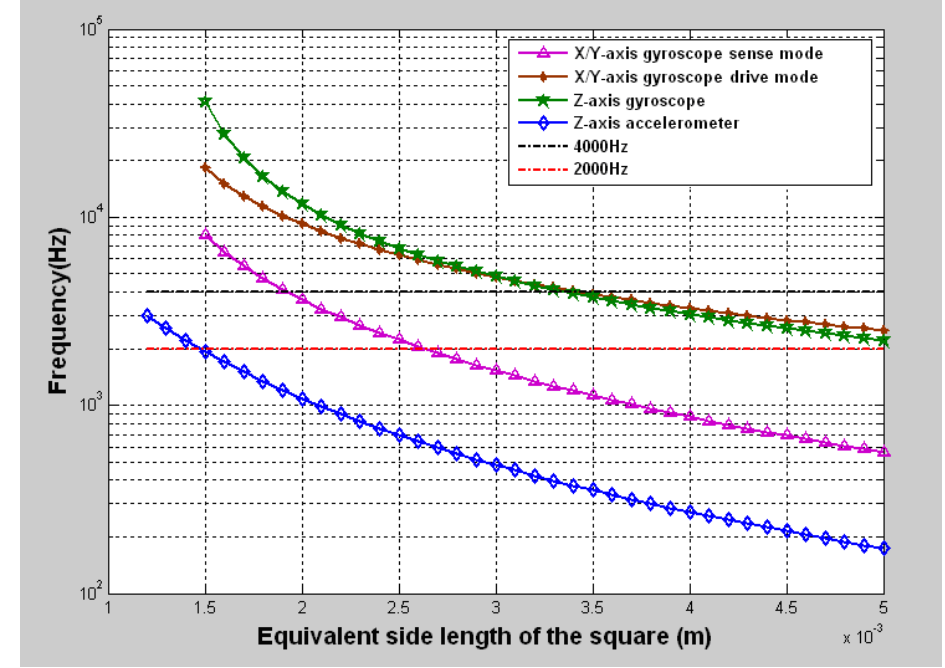
Figure 8. The natural resonant frequencies of the inertial sensors versus the layout